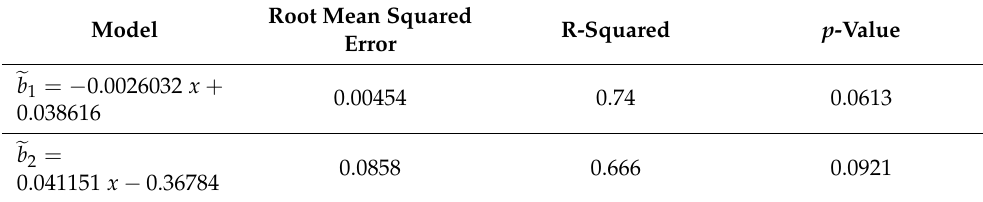
( 1 : 4 ) parameters’ values (procedure 6). Table 23. Vectors ˆ C sp 1 Parameter